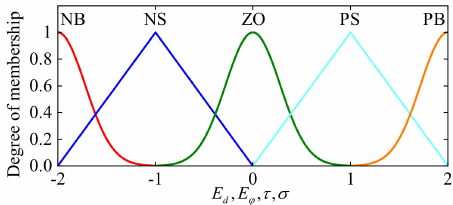
Figure 16. Membership functions of E d , E ϕ , τ , σ .